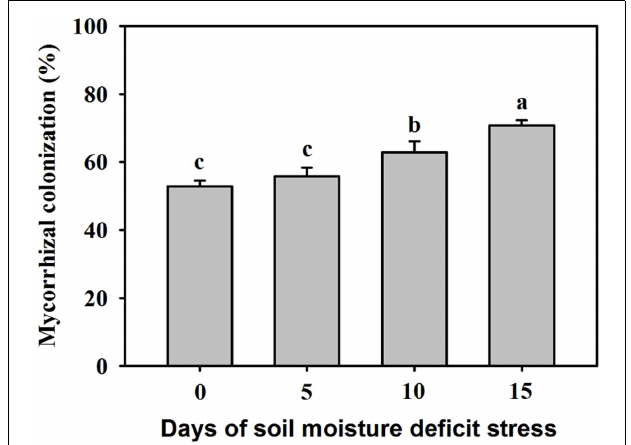
FIGURE 1 | Root mycorrhizal colonization of trifoliate orange seedlings inoculated with Funneliformis mosseae during 0-15 days of soil moisture deficit stress (SMDS). Data (mean ± SD, n = 4) followed by different letters above the bars indicate significant ( P < 0.05) differences.